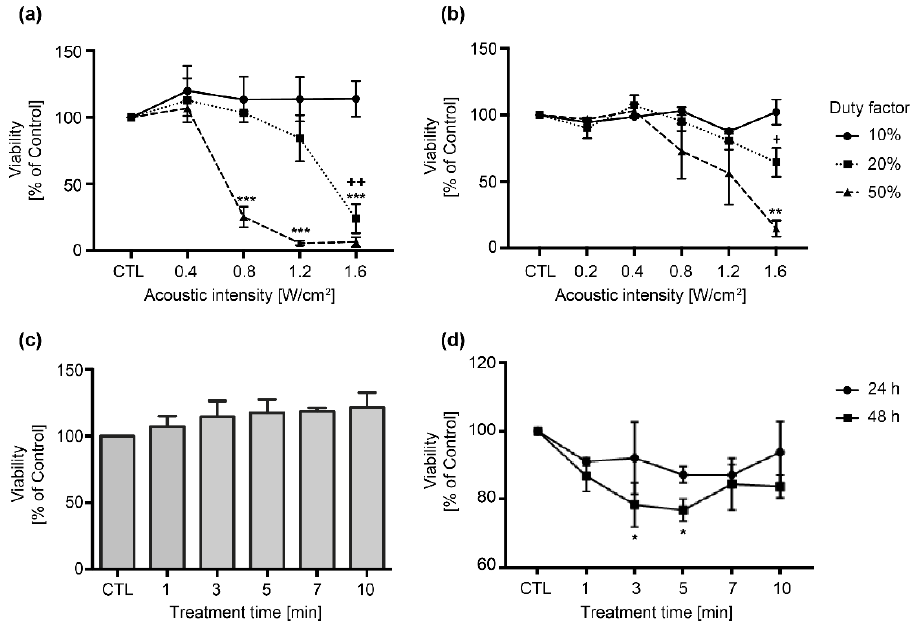
Figure 2. ( a , b ) Viability of MIO-M1 cells at different acoustic intensities and duty factors (10%, 20% and 50%) for 1 min of treatment when using ( a ) well-on-transducer setup ( ++ p < 0.01, CTL vs. 1.6 W/cm 2 , 20% DF; *** p < 0.001, CTL vs. 0.8–1.6 W/cm 2 , 50% DF; post-hoc Dunnett’s test), and ( b ) well-on-water-surface setup ( + p < 0.05, post-hoc Dunn’s test; ** p < 0.01, post-hoc Dunnett’s test). ( c , d ) Viability of MIO-M1 for different treatment durations with 0.4 W/cm 2 at 20% DF evaluated with the water-based setup ( c ) 24 h after treatment, ( d ) 24 h and 48 h post-LIPUS treatment and sub-culturing (* p < 0.05, post-hoc Dunnett’s test). All experiments were performed in triplicate, except for the viability curves at 10% DF through gel ( a ) and 24 h after LIPUS treatment and cell passaging ( d ), which were performed by